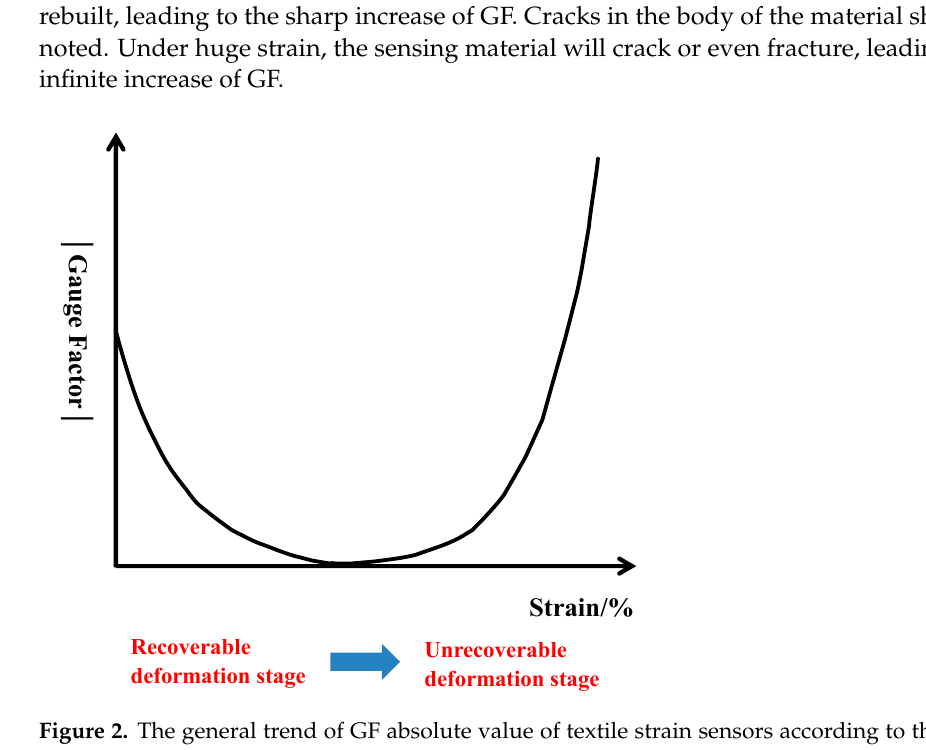
Figure 2. The general trend of GF absolute value of textile strain sensors according to their struc- ture variation.